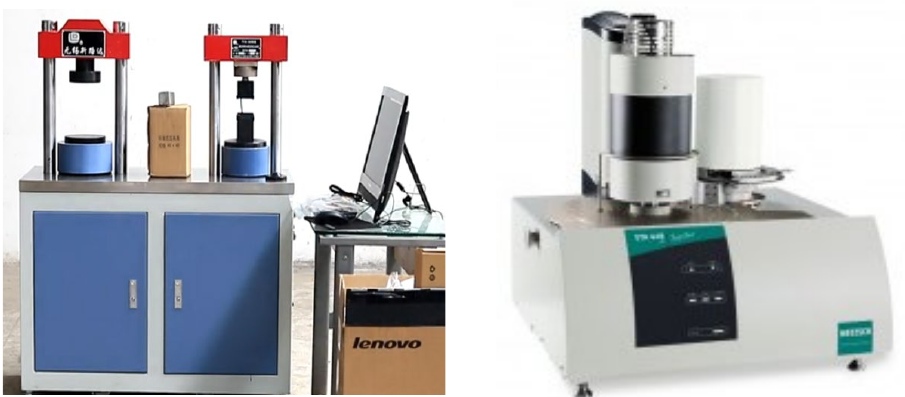
Figure 11. Left: TyA-300B compression and flexometer; Right: STA449F5 synchronous thermal analyzer.